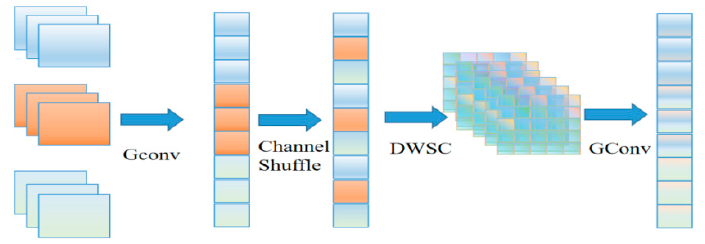
Figure 5. Structure of the block of convolutional neural network branch.